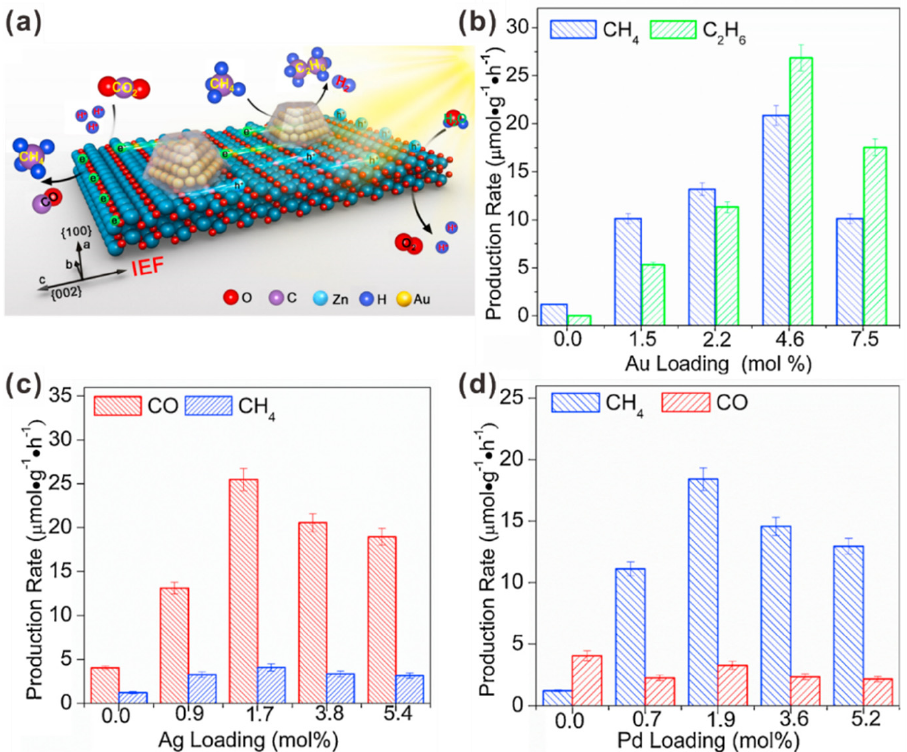
Figure 3. ( a ) Schematic illustration of the photocatalytic conversion of CO 2 to C 2 H 6 using Au/ZnO nanosheets, and the hydrocarbon production rates from CO 2 with loading plasmonic metals of ( b ) Au, ( c ) Ag, and ( d ) Pd to ZnO. Reproduced with permission from Reference [78]. Copyright 2019 Elsevier.